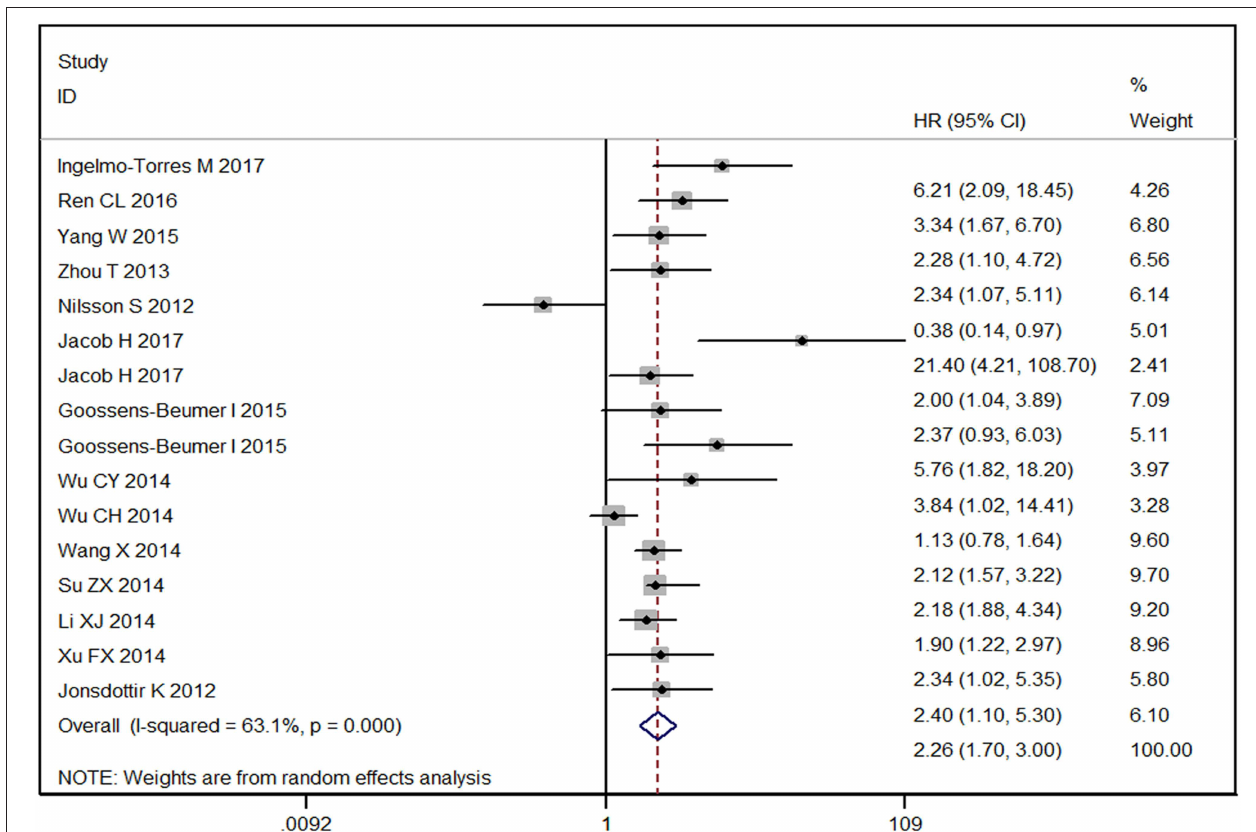
FIGURE 3 | Forest plot of the prognostic meta-analysis of the association between miR-92a family and the risk of cancers. HR, hazard radio; 95% CI, 95% confidence interval.